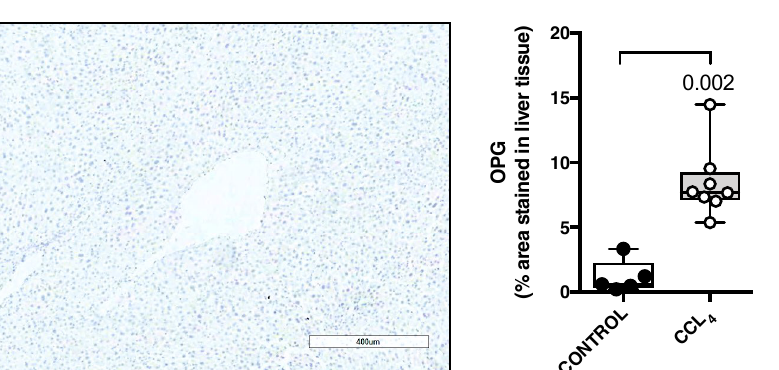
Figure 2. Osteoprotegerin levels are higher in murine fibrotic livers. OPG levels were higher in serum ( A ) and liver tissue lysates ( B ) of mice treated with CCl 4 for 8 weeks compared to untreated control mice. ( C ) Immunohistochemical staining of OPG expression in control mouse livers showed di ff use staining and no clear positive cells (50 × magnification). ( D ) In CCl 4 -treated mouse livers pronounced OPG expression in fibrotic bands (fb) was found (50 × magnification). ( E ) Negative control for the OPG staining (50 × magnification). ( F ) Quantification of this OPG staining showed higher expression in CCl 4 -treated livers as compared to control. Groups were compared using Mann–Whitney U, p < 0.05 was considered